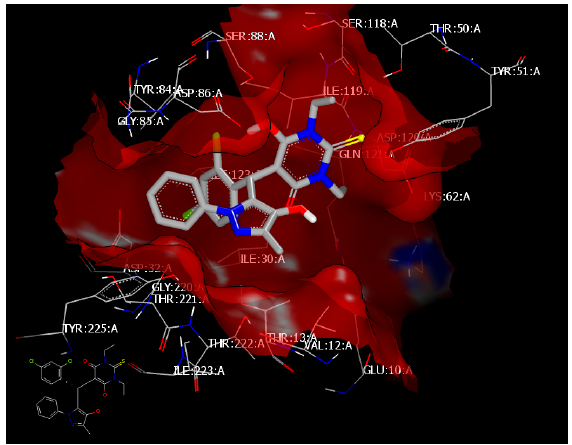
Figure 4. Visual representation of 4l showed the hydrophobic–hydrophobic interaction with the binding site of 3Q70, as shown by Vida.